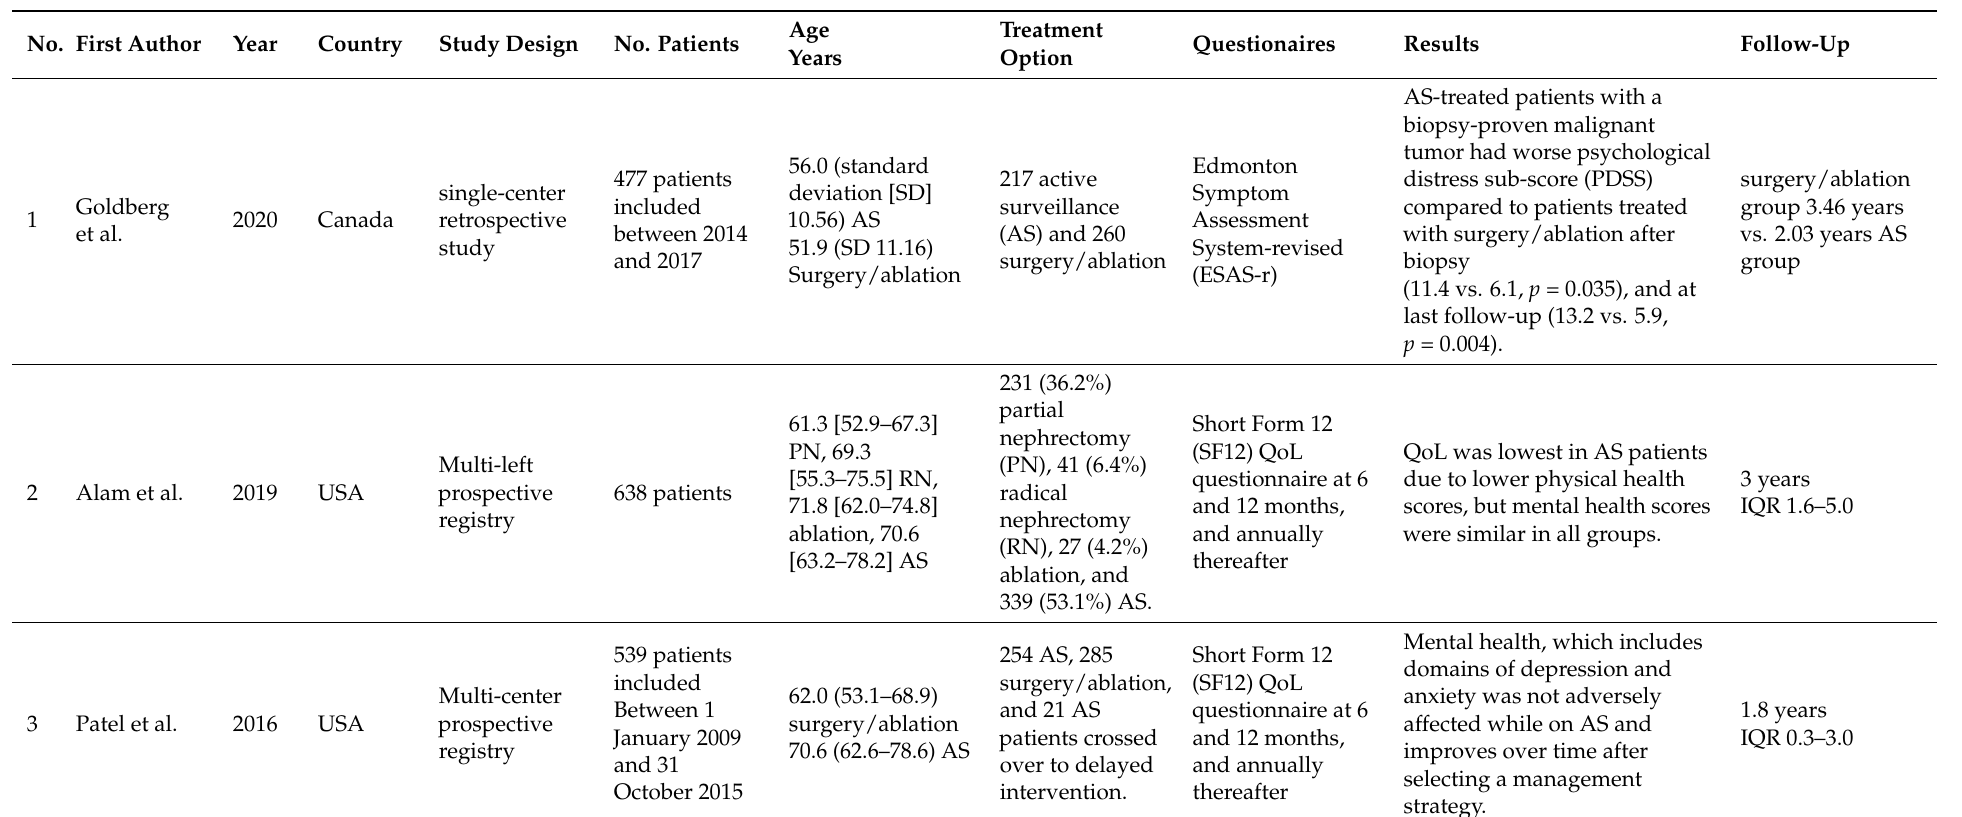
Table 1. Studies that assessed the impact of quality of life (QoL) or psychological distress on patients with small renal masses (SRMs) that underwent active surveillance (AS) compared to ablation/surgical